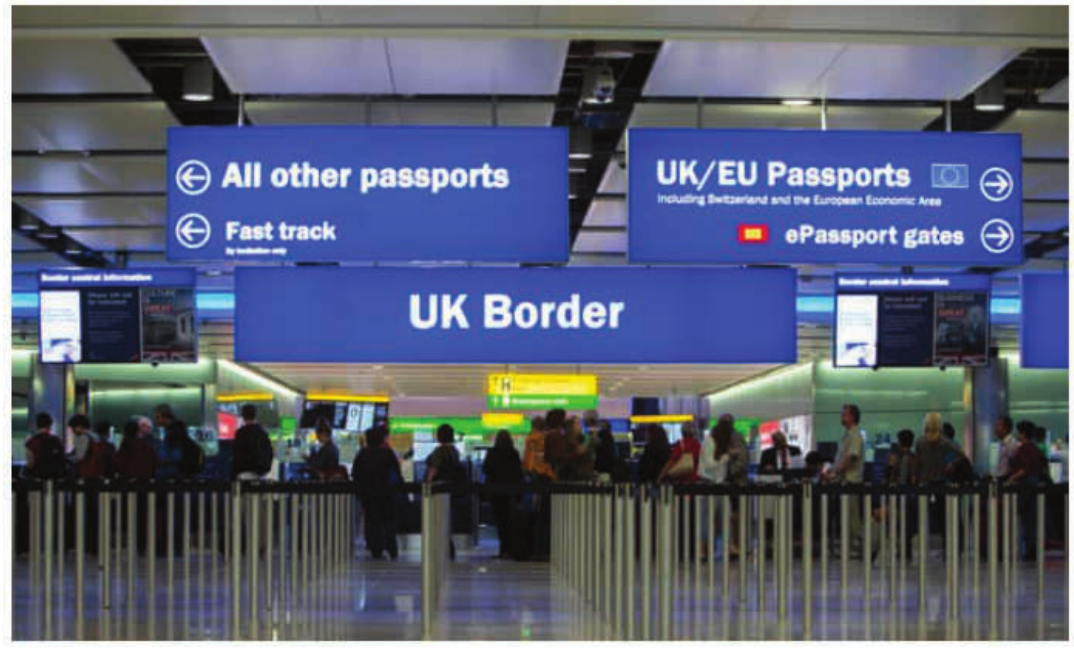
Figure 2: The ONS said net migration remained at record levels. Photograph: Steve Parsons/PA (GUA), https://www.theguar- dian.com/world/2016/aug/25/net-migration-to-uk-fell-to-327000-in-past-year-figures-show (date of last access: